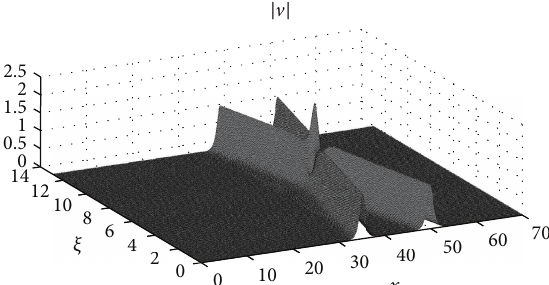
) , 𝑒(𝑥) = 𝐴 sech 𝑝 (𝑥 − 𝑥 ) , and 𝑝 = 3 . Solid line: 𝐴 = 0 ; that is, 𝑒 ≡ 0 . 0 0